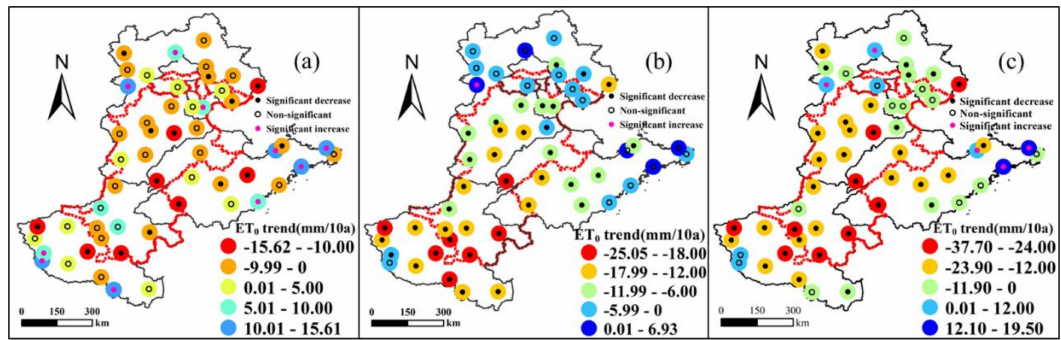
Figure 9. The spatial distribution and statistical significance of the trends in evapotranspiration (ET 0 )